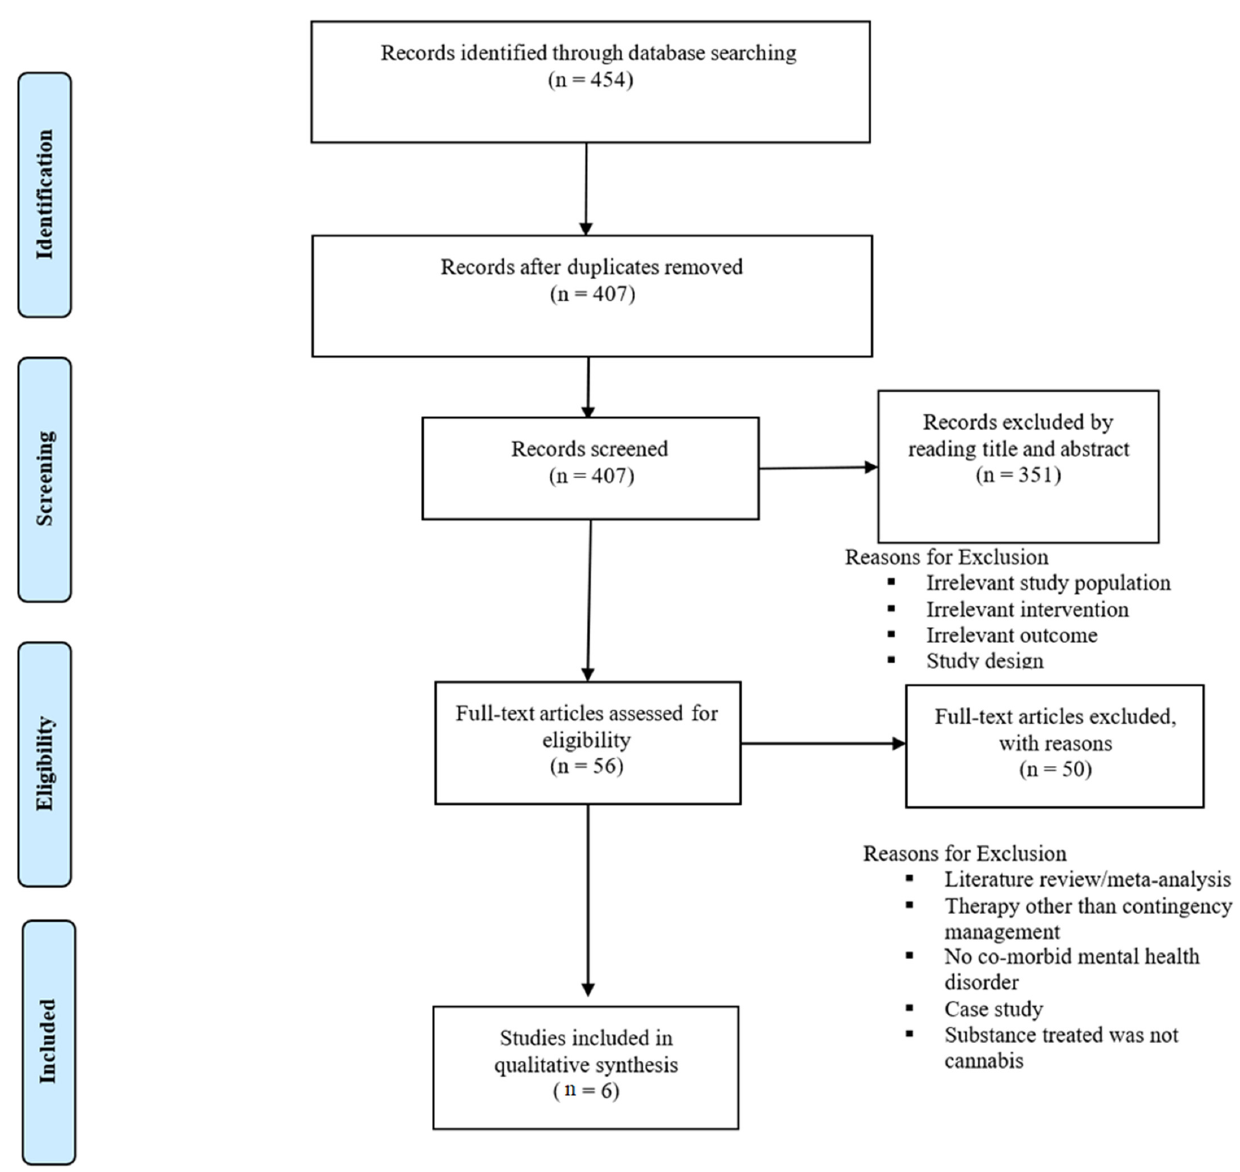
Figure 1. PRISMA Flow Diagram.